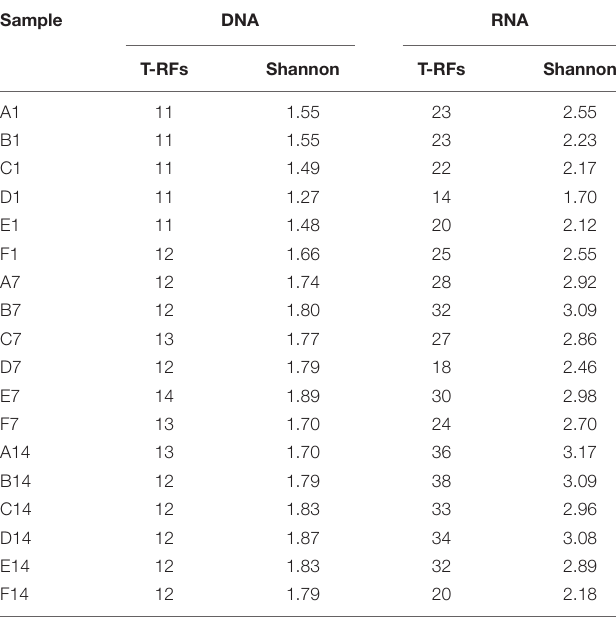
TABLE 1 | Numbers of T-RFs and T-RF-based Shannon